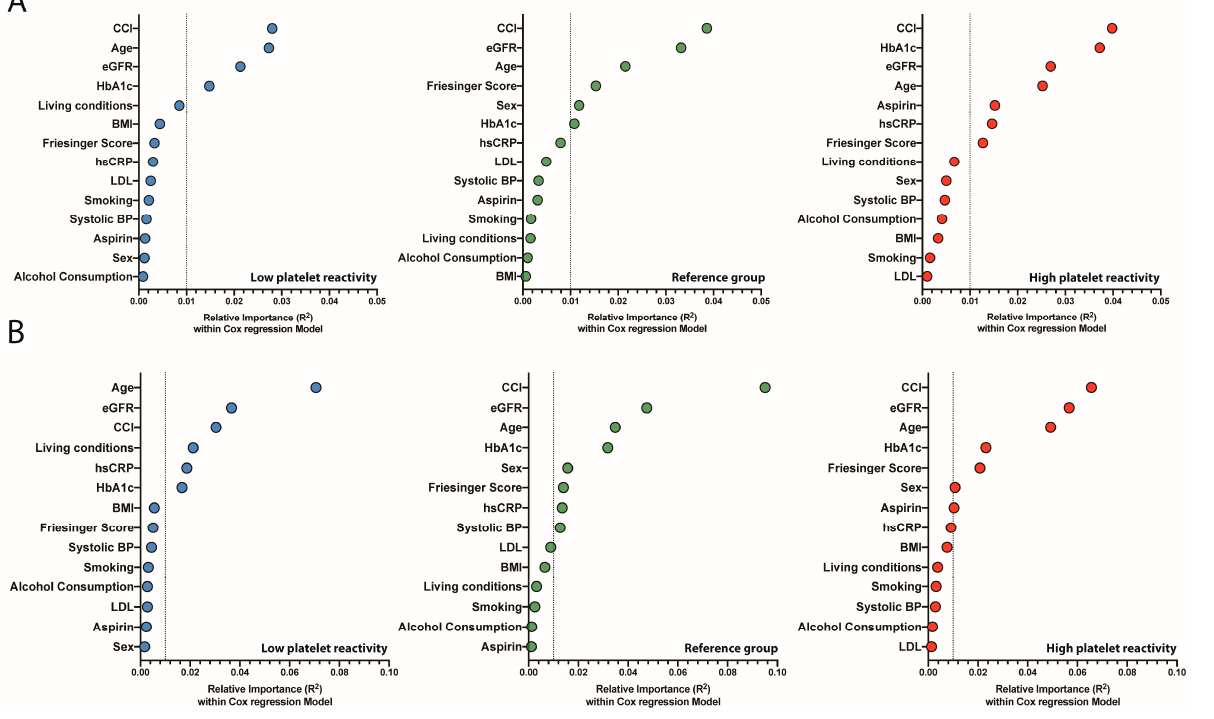
Figure 3. Relative Importance of risk factors that predict cardiovascular and all-cause mortality. Relative Importance analysis for 464 patients in the Low platelet reactivity group, 545 in the Reference group, and 511 in the High platelet reactivity group. The estimated relative importance denotes the strength of the association (R 2 ) for risk-factor variables for predicting cardiovascular ( A ) and all-cause mortality ( B ) among patients with High- and Low-platelet reactivity and the Reference group. The Cox model applied for this relative weight analysis is similar to model 4 in Figure 1. BMI—body mass index, eGFR—glomerular filtration rate, LDL-C—Low-density Lipoprotein, hsCRP—high-sensitive C-reactive Protein, CCI—Charlson Comorbidity Index; Blue circle—Low platelet reactivity; Green circle—Reference Group; Red circle—High platelet reactivity.